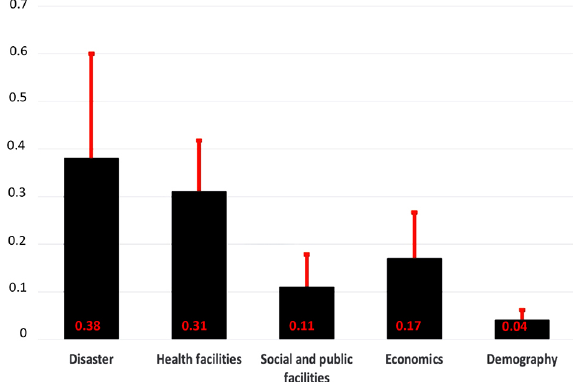
Fig. 8. The weight of each parameter in the first